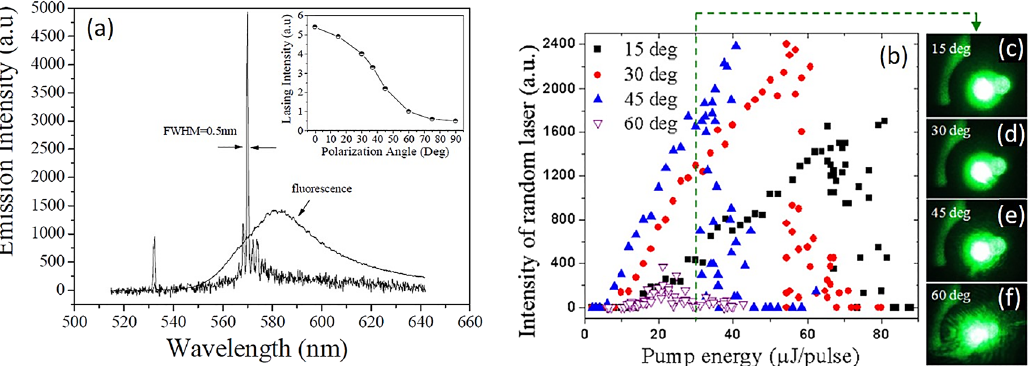
Figure 12: Fluorescence and lasing spectra are reported. Discrete sharp peaks emerge from the residual spontaneous emission for pump energy of about 1.2 μ